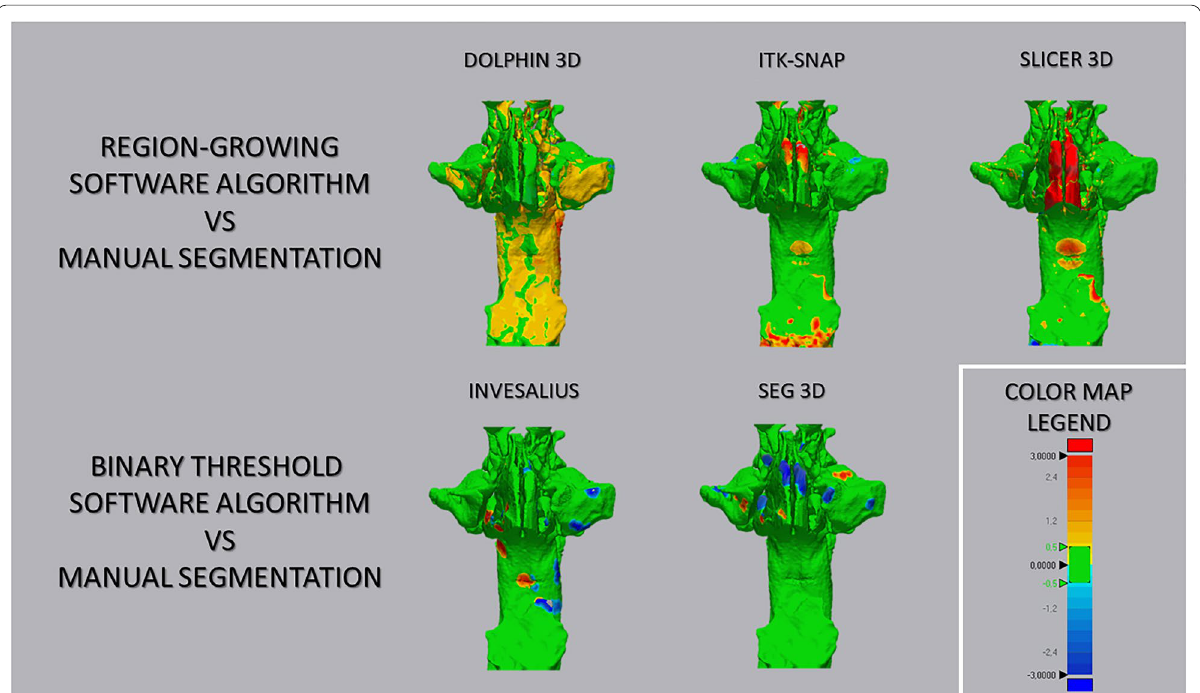
Fig. 5 Surface-to-surface matching technique between 3D upper airway models obtained with semi-automatic segmentation and its ground truth model (manual